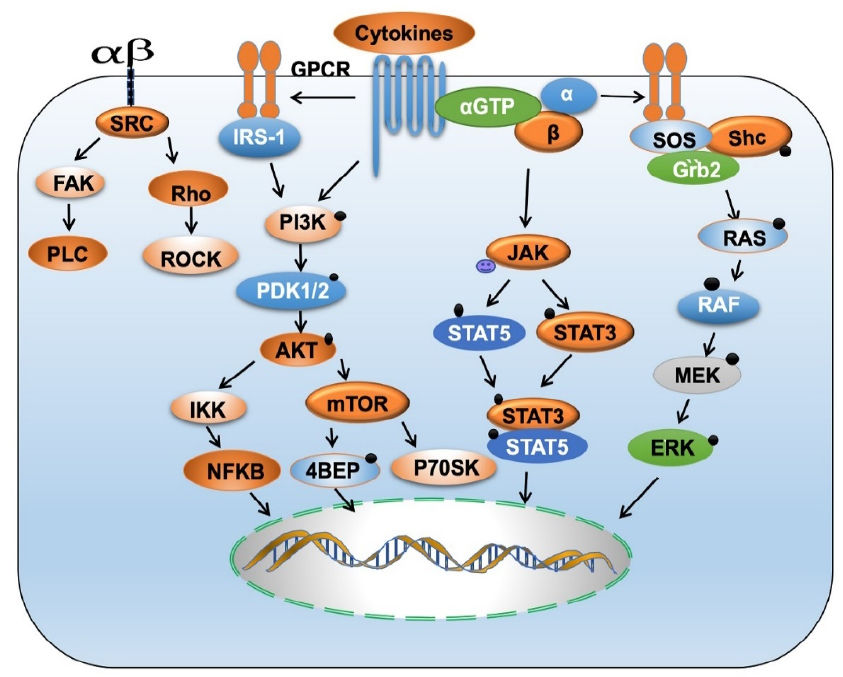
Figure 3. Cytokines/Chemokines activate signaling pathways. Chemokines/cytokines via trans- membrane protein GPCR activate an array of signaling pathways like PI3K/AKT/mTOR, JAK/STAT, RAS/RAF, integrin mediates SRC/FAK and Rho/RAC. Deregulation of these signaling pathways is known to promote initiation, progression, and metastasis in HNSCC.